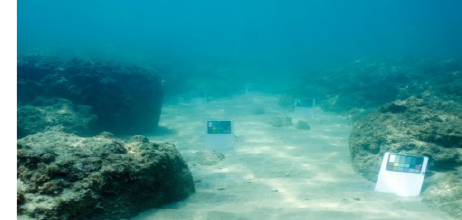
Fig. 2. Original Image .